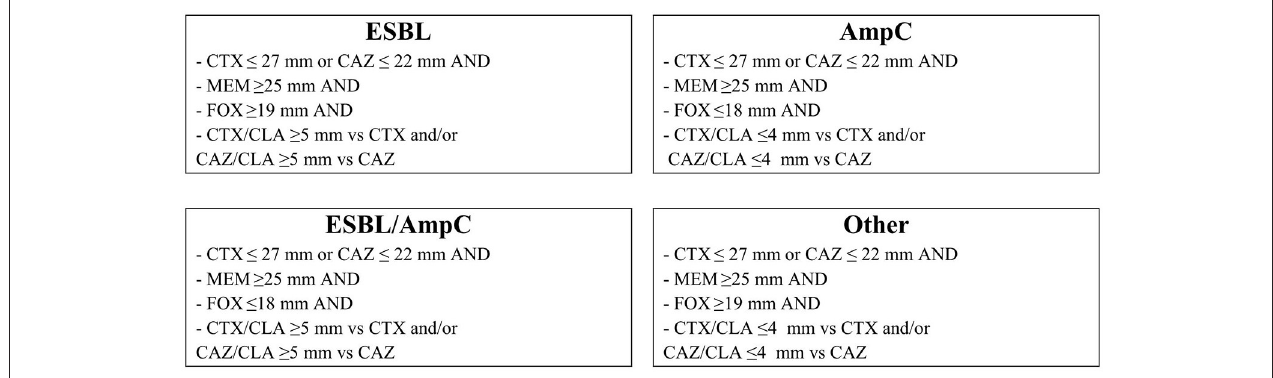
FIGURE 1 | ESBL/AmpC phenotypes by disk diffusion method derived from MIC by the European Committee on Antimicrobial Susceptibility Testing definition. CTX, CAZ, CTX/CLA, and CAZ/CLA are zone diameters from CLSI VET08 table 7A. FOX and MEM are zone diameters from EUCAST guidelines for detection of resistance mechanisms and specific resistances of clinical and/or epidemiological importance. CAZ ceftazidime (30 µ g); CLA clavulanate (10 µ g); CTX cefotaxime (30 µ g); FOX cefoxitin (30 µ g); MEM meropenem (10 µ